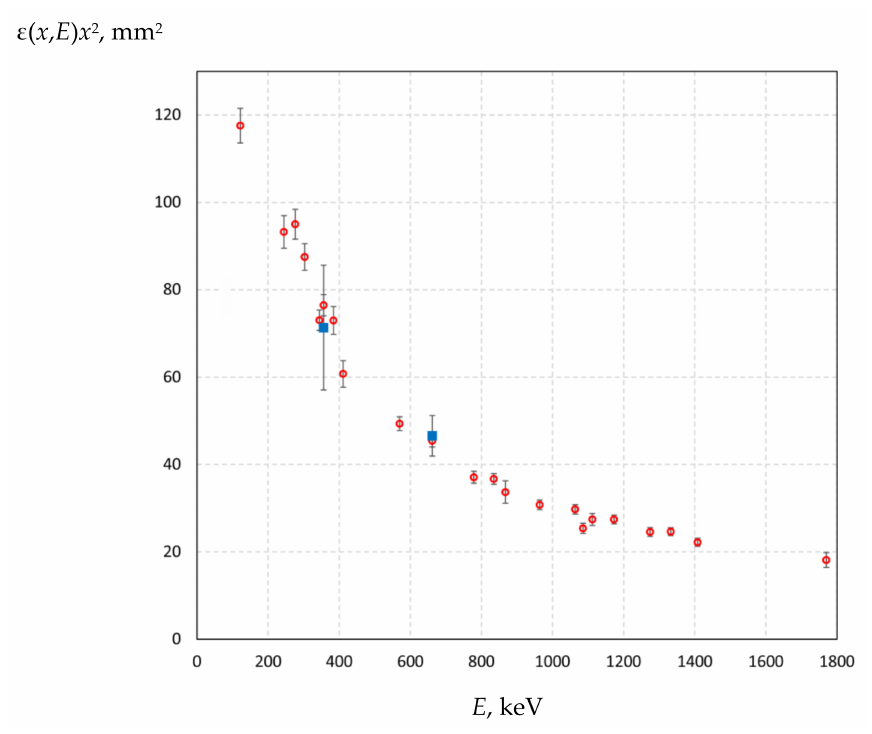
Figure 4. The dependence of the function ε ( x , E ) x 2 on the photon energy E : sources of photon radiation from the OSGI-RT set, (cid:4) — γ -radiation sources with barium-133 and cesium-137